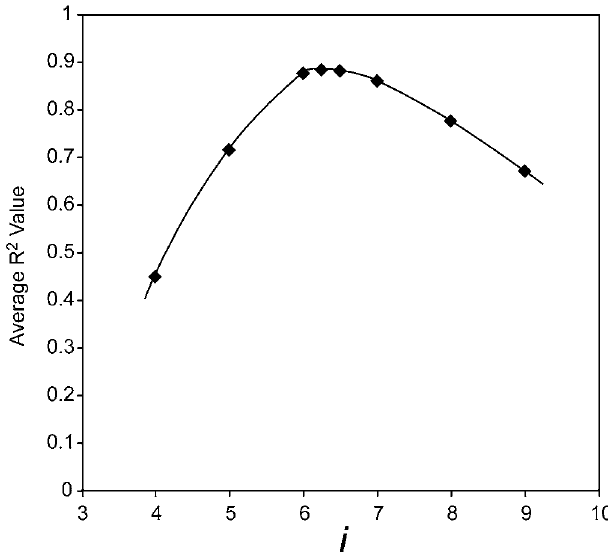
Figure 9. Quality of the Data Fitting, as Measured by R 2 , Varies with Changes in i